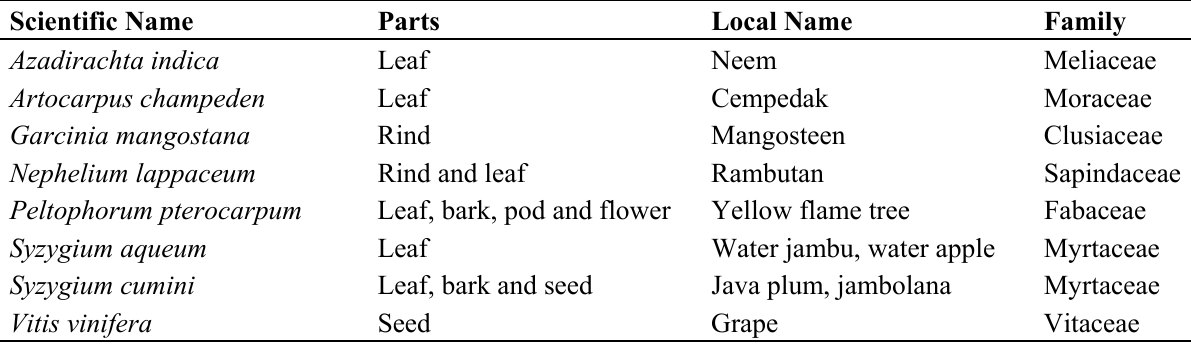
Table 1. The selected tropical plants; scientific name, parts, local name and